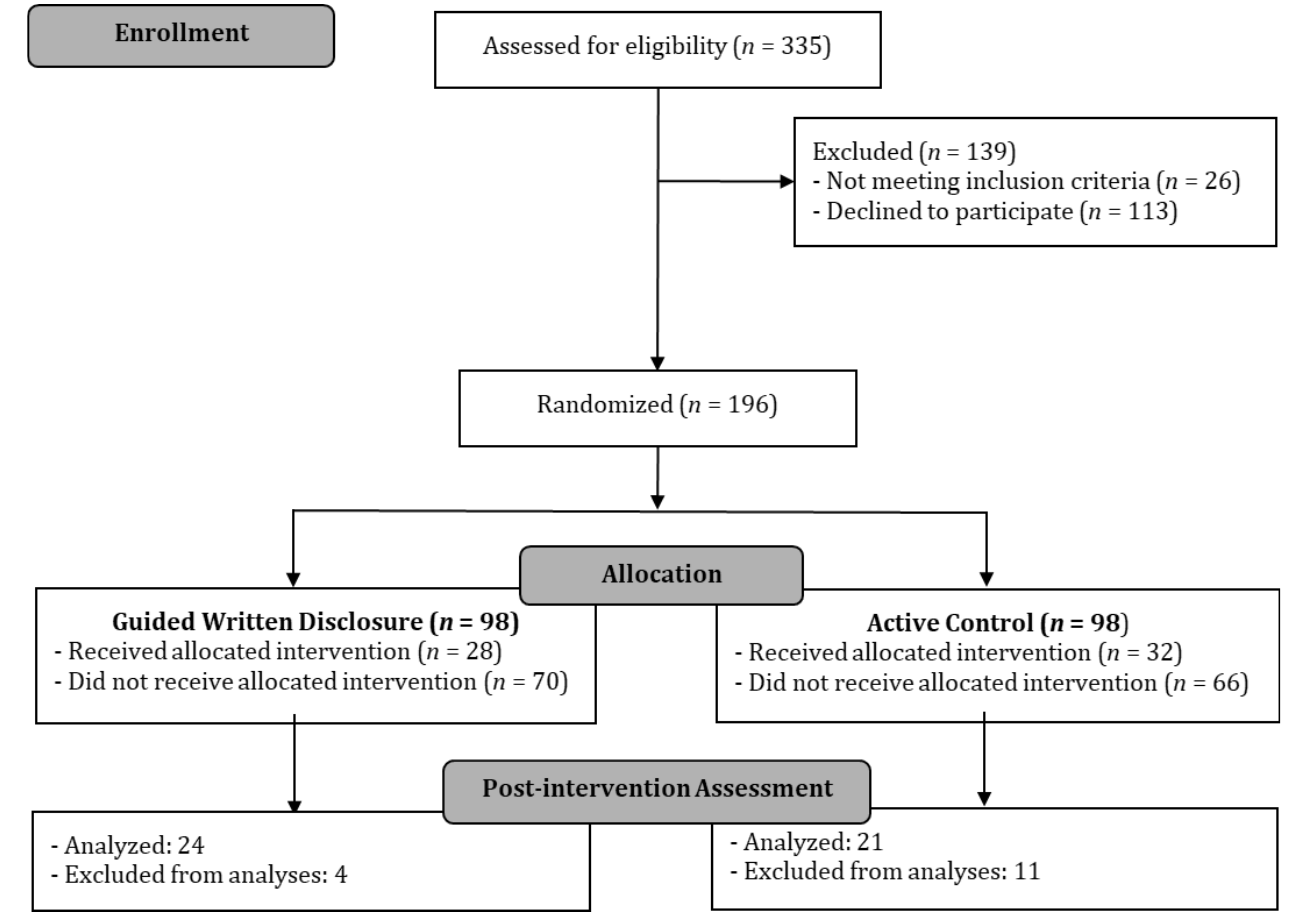
Figure 1. Flow chart of participants.